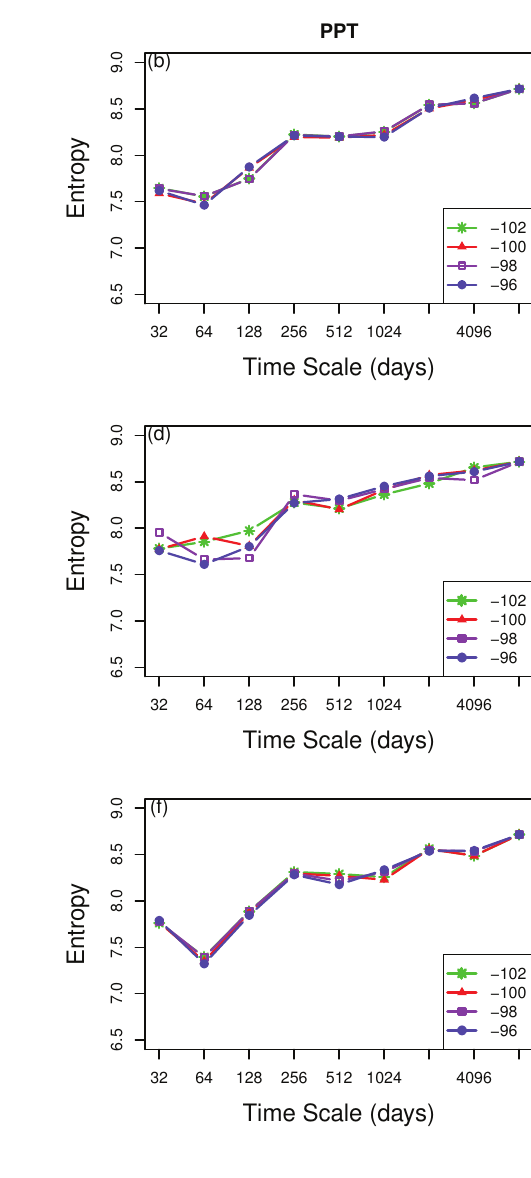
Figure 7. Multi-resolution entropy of NDVI ( left ) and PPT ( right ) as a function of temporal scale in ( a ) entire KRB; ( b ) whole KRB; ( c , d ) irrigated corn; ( e , f ) C4 grassland for selected longitudes: 102 W (green line with star), 100 W (red line with triangle), 98 W (purple line with rectangle) and 96 W (blue line with